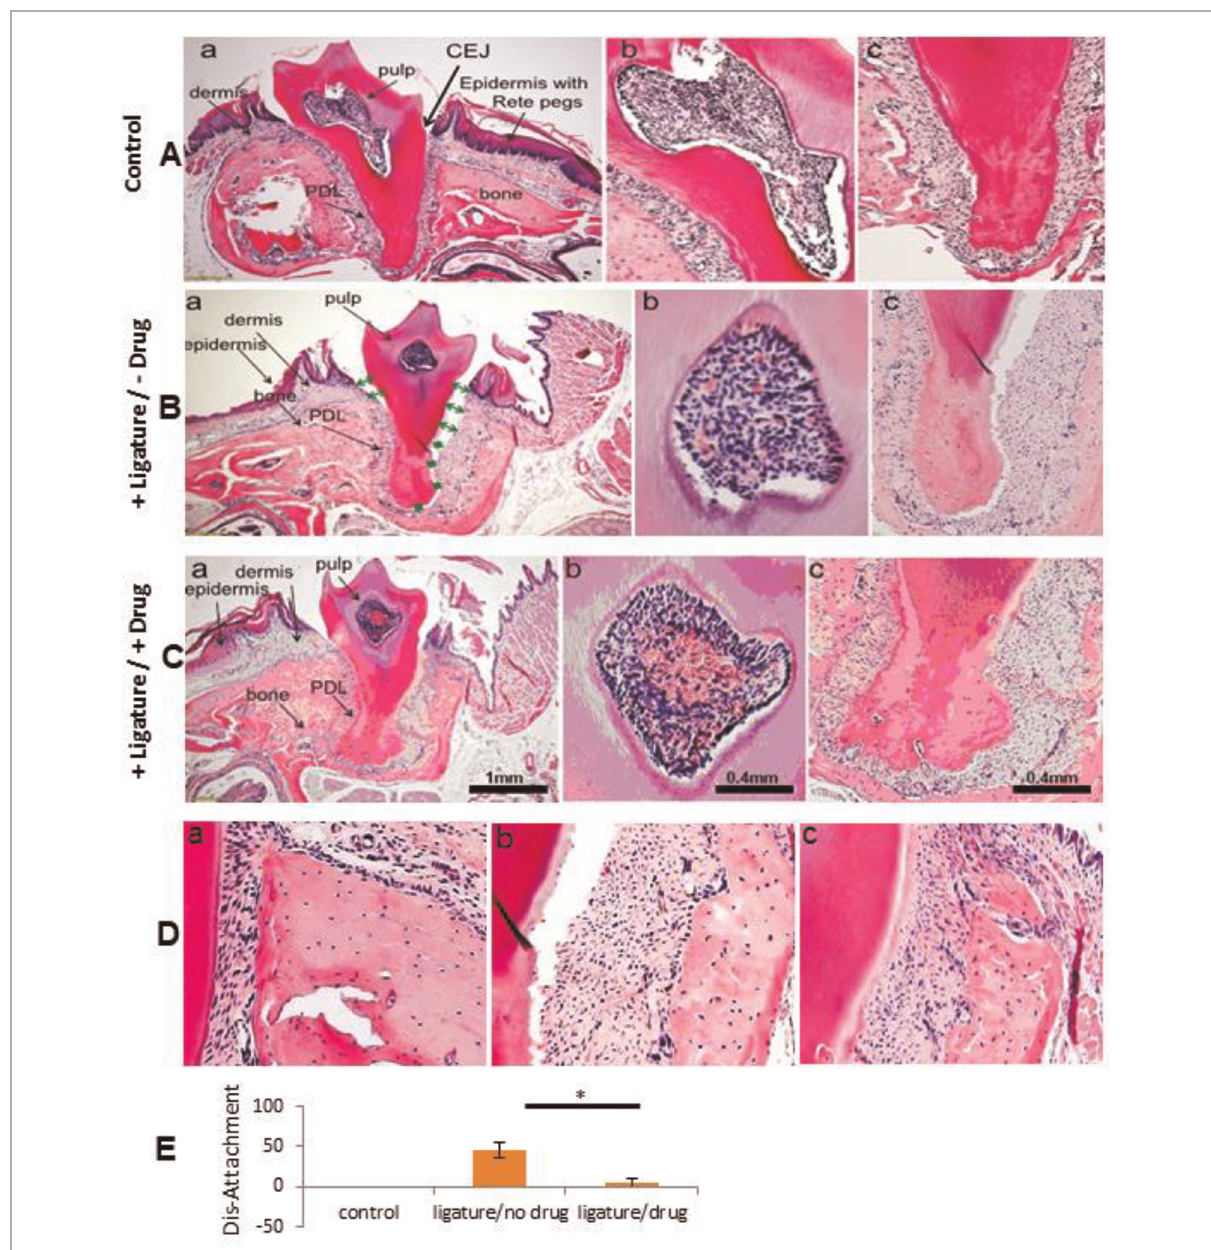
FIGURE 2 Histological analysis of normal and 20 days post-ligature +/- drug treated jaw tissue. In fi gure, H&E-stained lateral jaw sections of a maxillary second molar are seen. The scale bar = 1mm for ( A-Ca ). The scale bar = 0.4 mm for all other photomicrographs, marked and unmarked. In row A, a normal mouse maxilla is seen ( Aa-c ). In row B, a maxilla from a +ligature/-drug-treated mouse is seen ( Ba-c ); and in row C, a maxilla from a +ligature/ +DPCA-PEG-treated mouse ( Ca-c ) is seen on experimental day 30 (day 20 post ligature) and all samples are representative of 3 different mice for each condition. ( a ’ s ) show tooth and surrounding tissue; ( b ’ s ) show pulp; ( c ’ s ) show PDL. ( D ) shows a high magni fi cation of bone from a normal maxilla ( Da ), from a maxilla of a +ligature/-drug-treated mouse ( Db ), and from a maxilla of a +ligature/+DPCA-PEG-treated mouse ( Dc ). In the normal control mouse ( Aa ) is seen a thick gingival dermis and epidermis with Rete pegs, a rich periodontal ligament attachment extending from root tip to cemento-enamel junction (CEJ), with periodontal ligament fi bers and fi broblasts attached from tooth to normal bone ( Da ), along with pulp chamber and its rich cellular composition. The pathology induced from a silk ligature around the root adjacent to the crown is seen in ( Aab ). ( B,C ). In the +ligature-treated/-drug-treated mouse ( Bac ), a space between PDL and tooth extending to both sides of the tooth apex (green arrows, stars) is seen. Breakdown of dermis and epidermis surrounding the tooth crown with obvious dis-attachment of PDL to root surface results in a deep invagination extending > 60% of the length of the CEJ to tooth APEX. PDL is totally eliminated on the right of ( Bac ) and partially obliterated on the left side. Epidermis and dermis are tattered and edematous. Bone shows porous changes ( Db ) and clinically this tooth would be highly mobile within the tooth socket and correspond in humans to advanced PD involvement within an indication for extraction. The jaw in ( Ca ) is from a +ligature/+drug-treated (2 doses DPCA-PEG, da0, da8 post-ligature) mouse. Here, PDL is attached to bone ( Dc ) and tooth, dermis is richer than without drug-treatment. Pulp shows higher levels of blood cells and vessels. A higher magni fi cation of pulp shows differences with different treatments ( Ab,Bb,Cb ). After drug treatment, the pulp is richer with higher levels of red cells and angiogenesis compared to both normal and ligature alone-treated mice